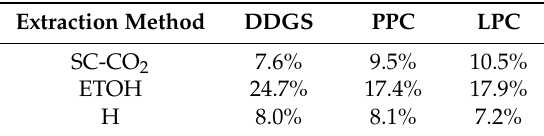
Table 5. Extraction yields (%) from DDGS, PPC, and LPC using various